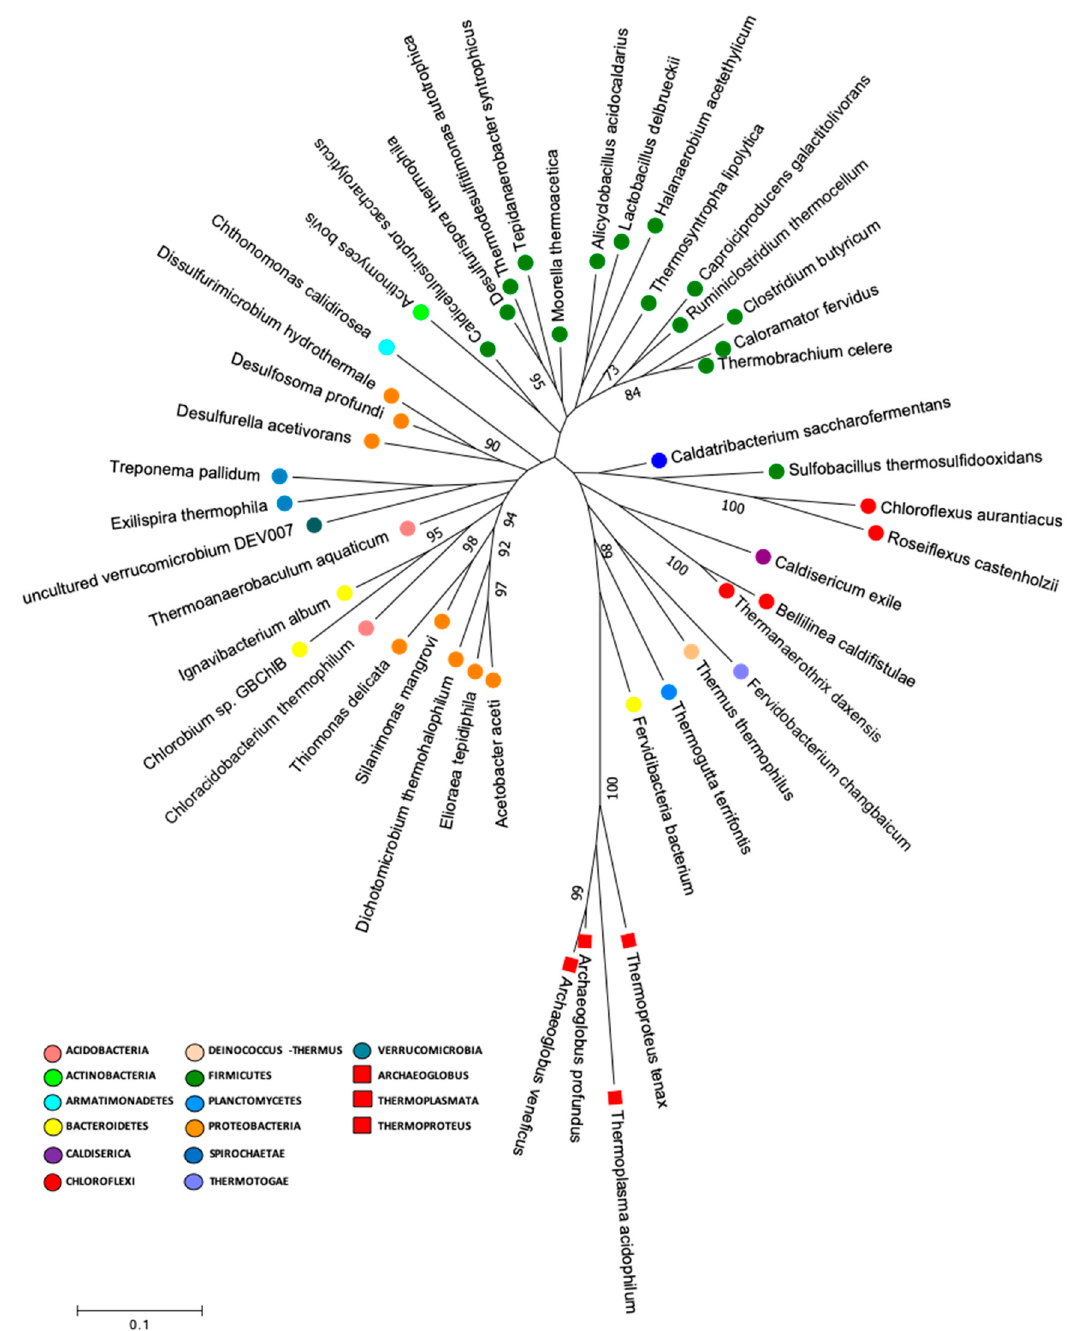
Figure 6. Molecular phylogenetic analysis of early life genera. The evolutionary history was inferred by using maximum likelihood method based on the Tamura – Nei model with one hundred bootstraps to assign confidence levels to the nodes of the trees, (MEGA version